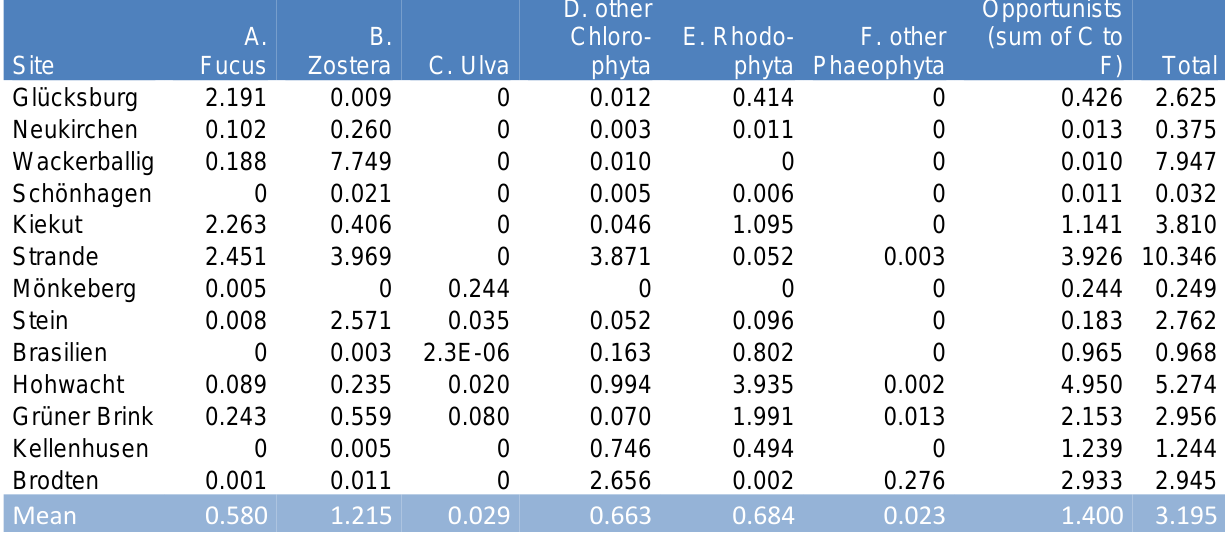
Table S3A: Mean dry matter of different macrophytes in beach wrack sampled in 2012 and 2013, related to length of beach line [kg m -1 ]